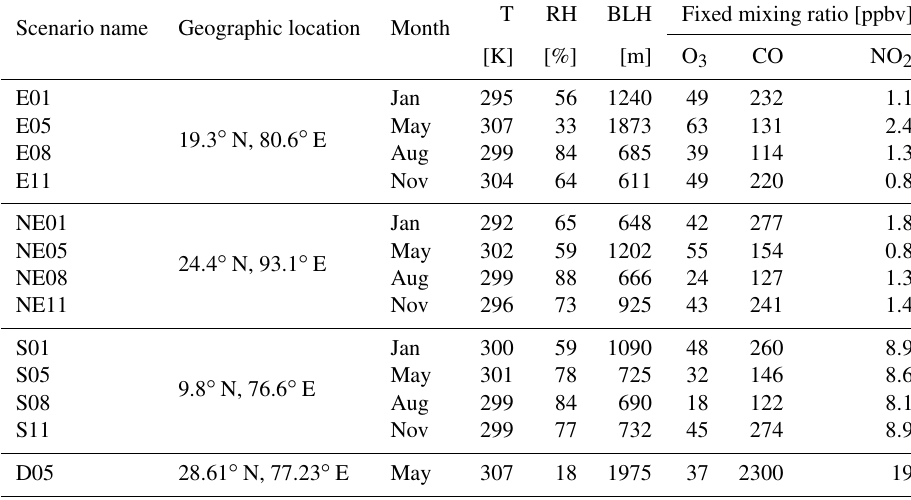
Table 1. Photochemical and meteorological scenarios used for box model calculations. The emboldened letters E, NE, S denote the forested regions (Fig. 1), and D denotes Delhi. Ground-level temperature ( T ), relative humidity (RH), boundary layer height (BLH) and mixing ratios are GEOS-Chem monthly mean values from each